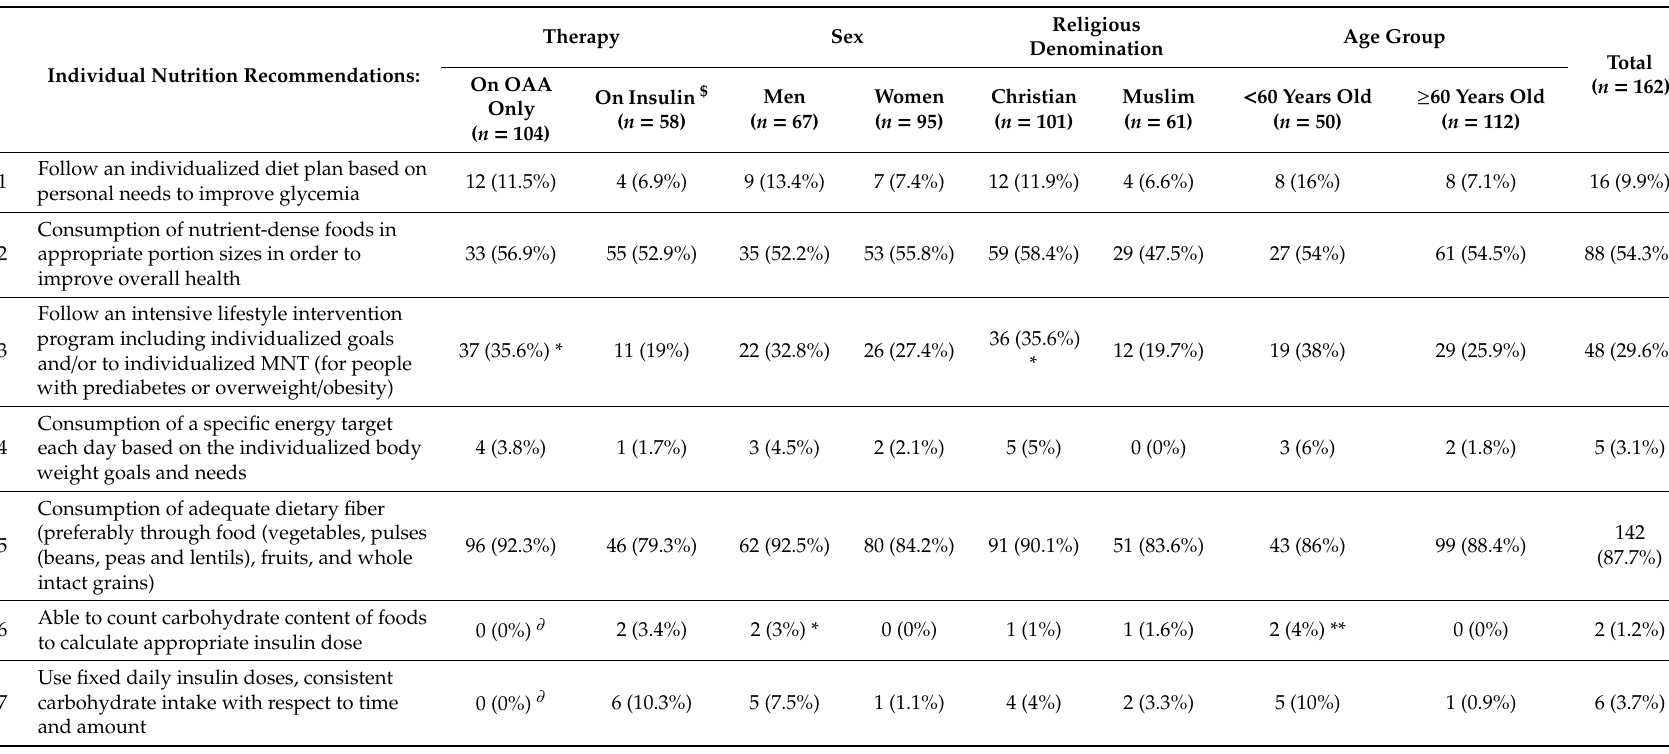
Table 2. Patient adherence to individual nutrition recommendations suggested by the American Diabetes Association (ADA) ( n = 162) ( n , % or median, interquartile range